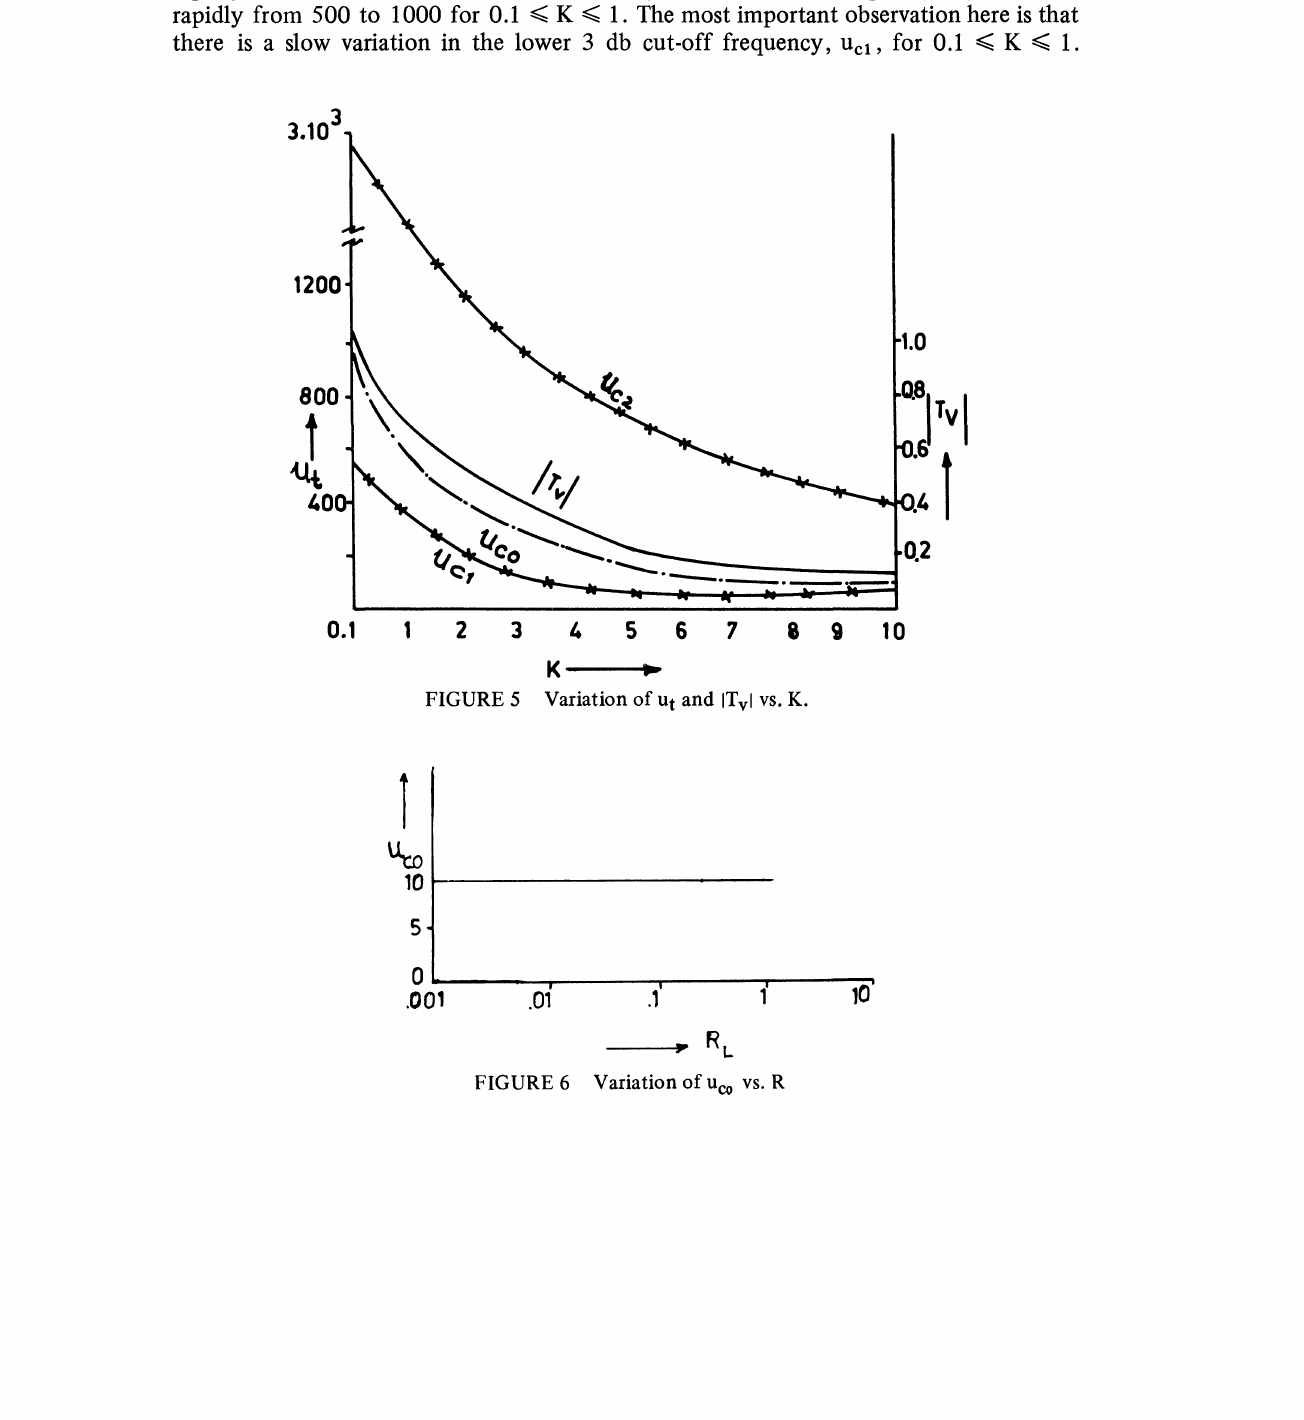
FIGURE 5 Variation of u and ITvl vs. K.